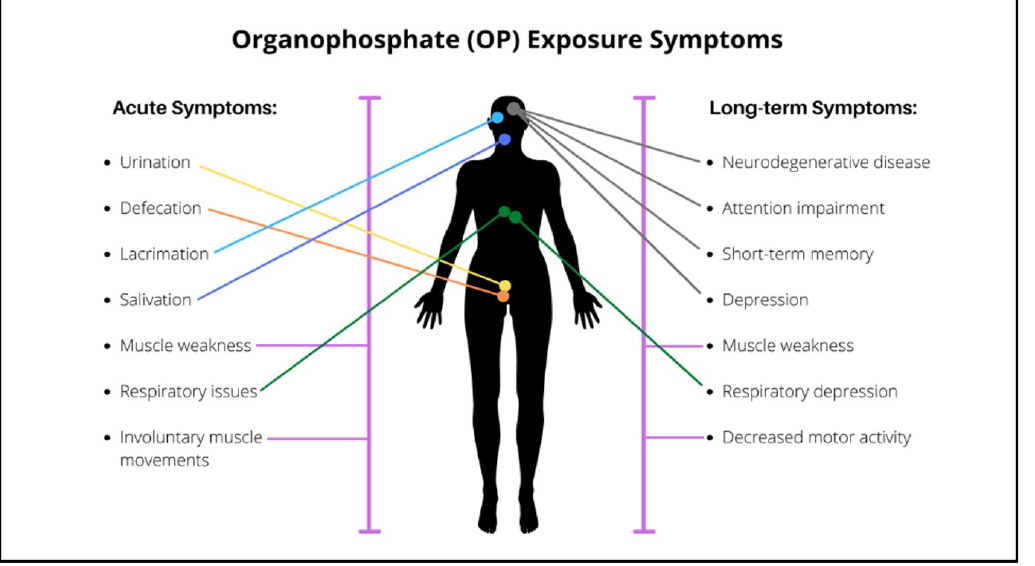
Figure 3. The major consequences of OP exposure in humans.